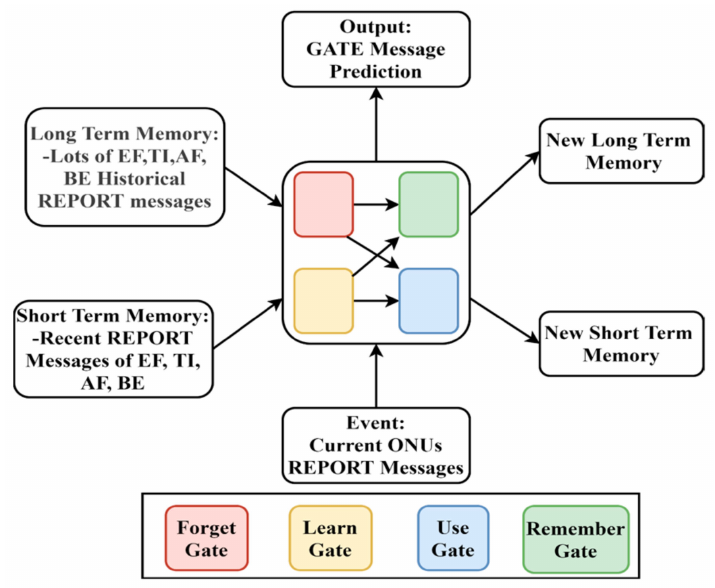
Figure 4. LSTM architecture for DWBA prediction